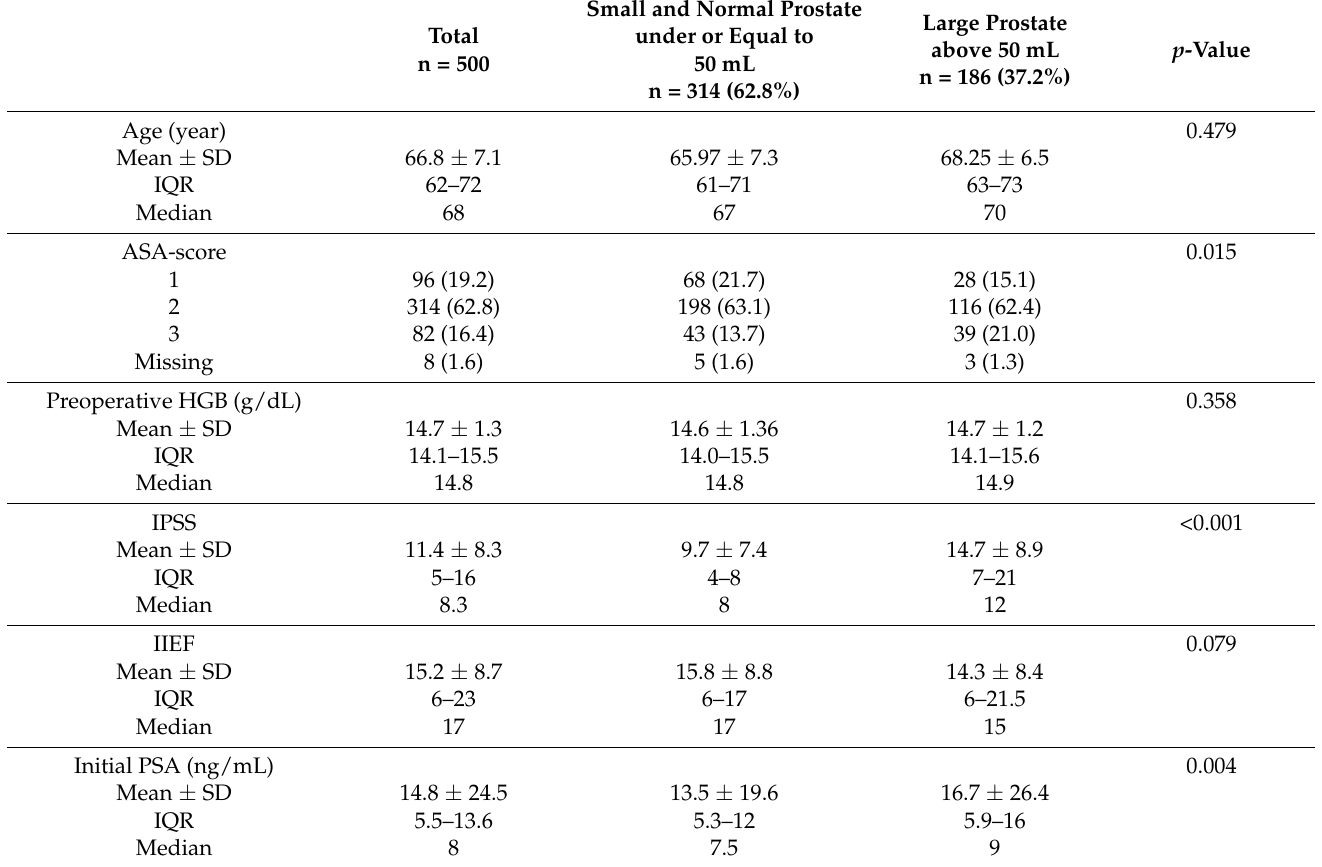
Large Prostate above 50